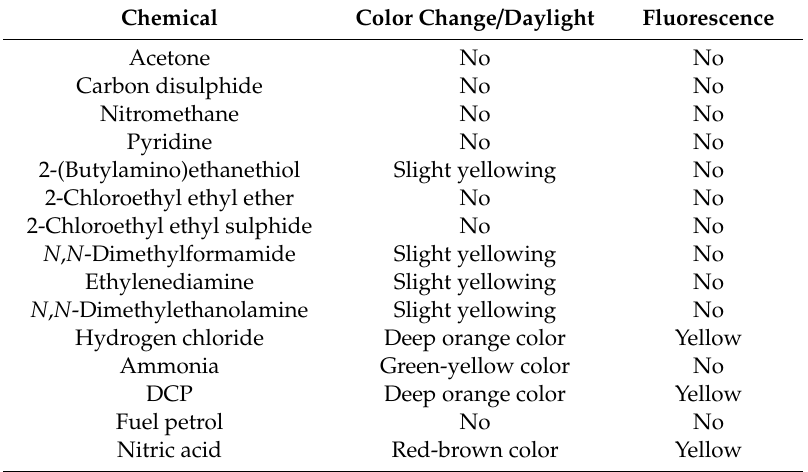
Table 2. Interference (C20.0, M20.0), sample volume 1 dm 3 (vapor above an open bottle).